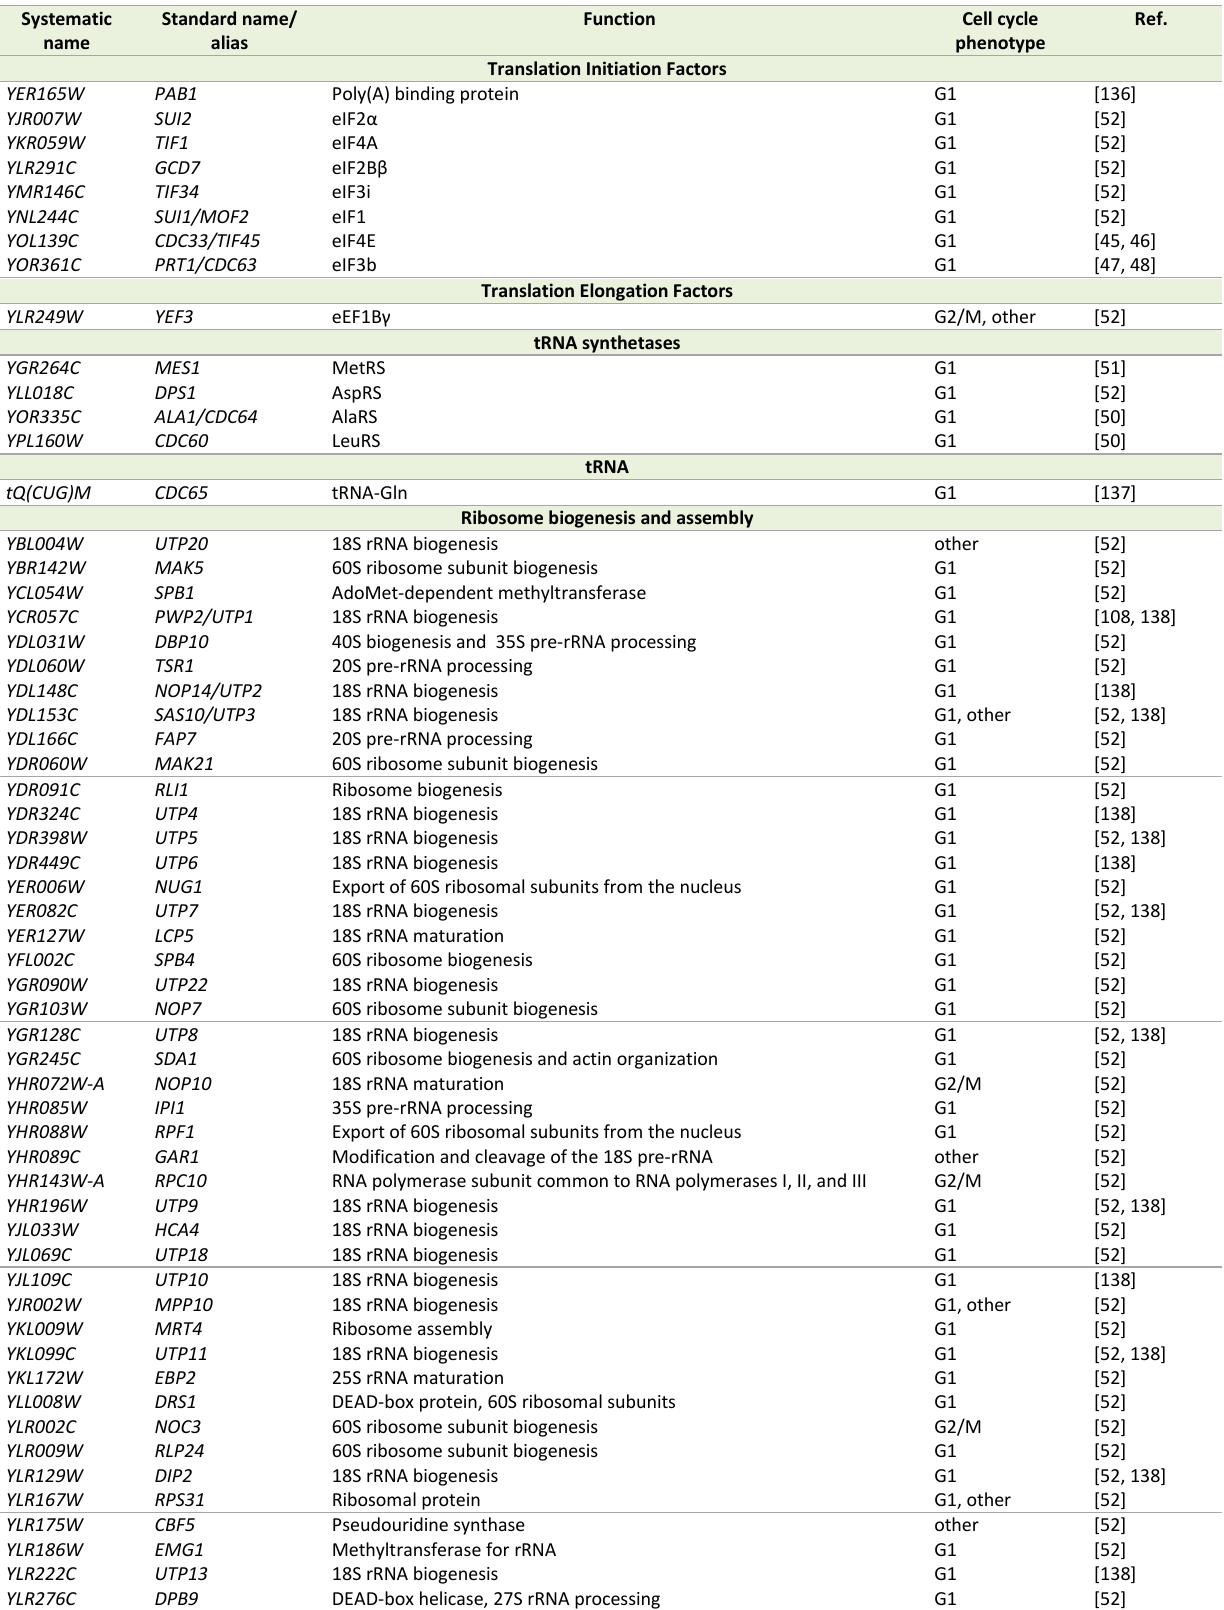
TABLE 1. Cell cycle phenotypes of loss-of-function mutants in essential genes encoding protein synthesis and ribosome biogenesis factors in S.